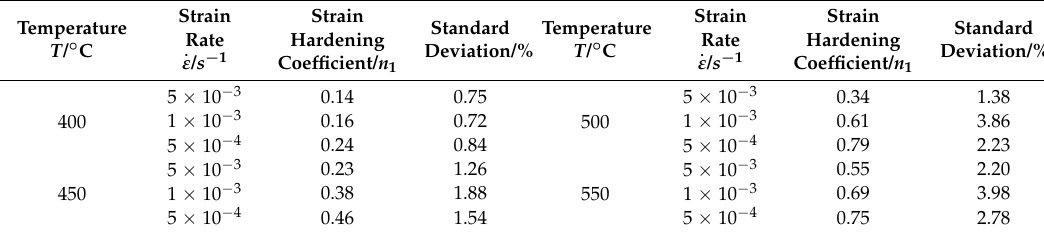
Table 1. Coefficients of strain hardening at different temperatures and strain rates.